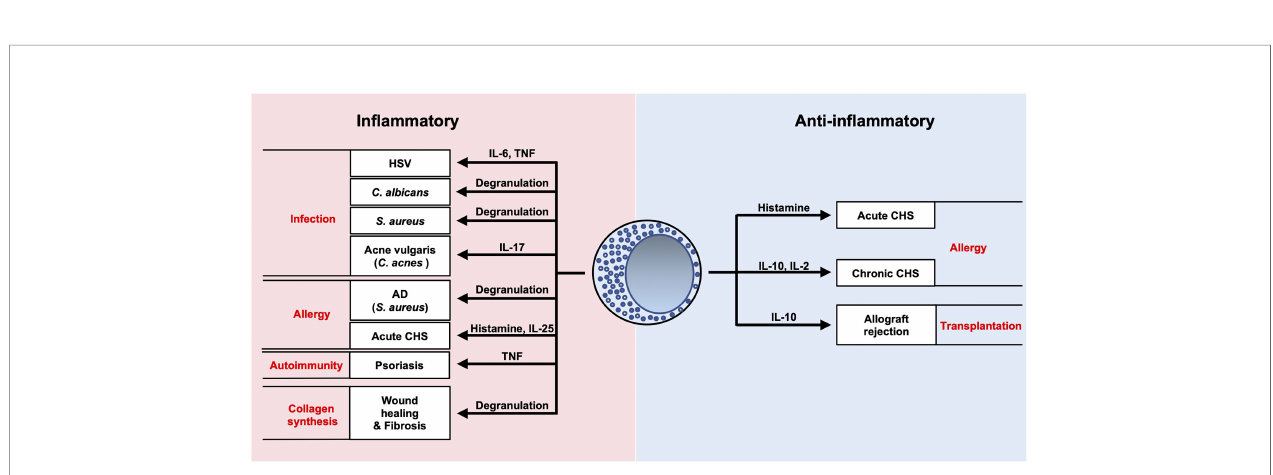
FIGURE 7 | Summary of roles of mast cells in cutaneous diseases. Mast cells are potential sources of in fl ammatory and/or regulatory mediators during development of various cutaneous infections and